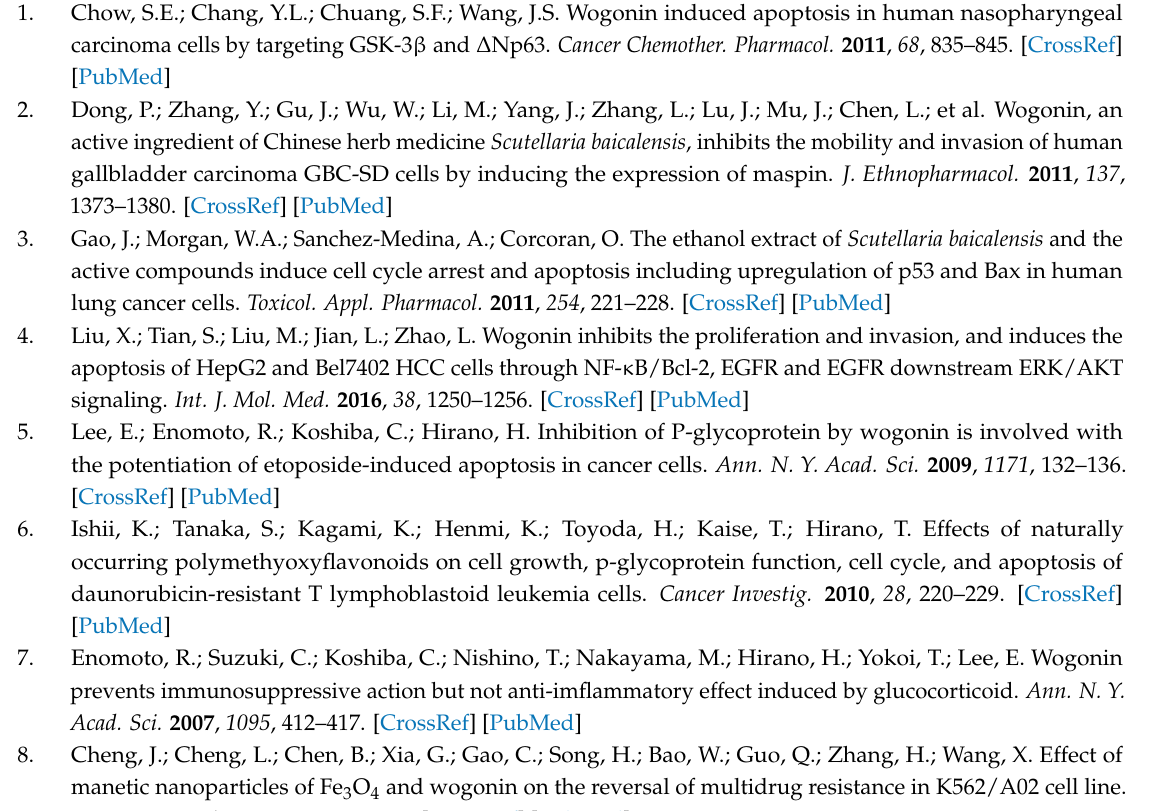
Figure S1. Stability test of W-SLN (F2). Particle size, zeta potential and encapsulation efficiency of W-SLN was monitored up to 60 days at room temperature ( n = 3, mean ± SD). Figure S2. HPLC profile of wogonin for (A) E.E (%) measurement and (B) cellular uptake